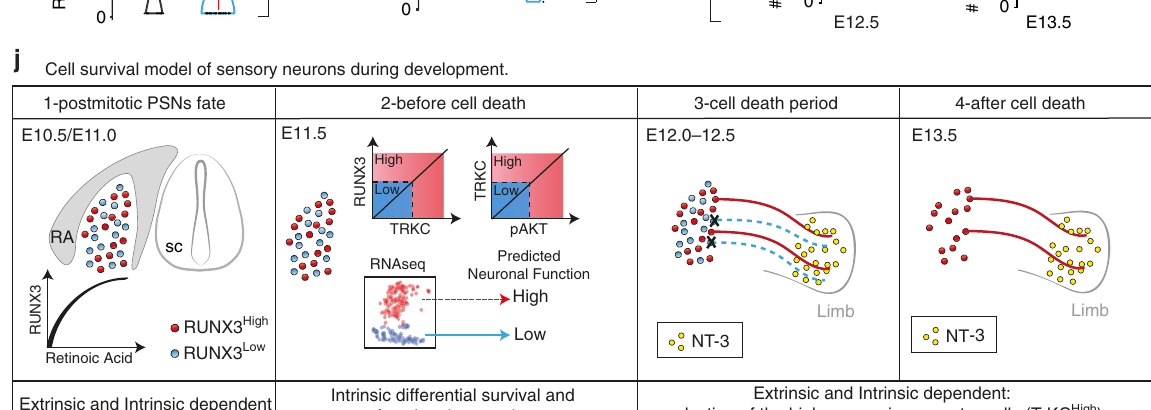
Fig. 6 Retinoic acid signaling regulates induction of RUNX3 expression in PSNs. a Section of the brachial region of an HHst23 chicken embryo showing expression of the RA-synthesizing enzyme RALDH2 at the time of physiological induction of RUNX3. Scale bar: 50 μ m. b RUNX3 expression is induced in the presence of RA (500 ng/ml) in a subset of ISL1 + DRG neurons from HHst23 embryos within 12 h of treatment. Scale bar: 50 μ m. c Concentration- dependent response of RA treatment on RUNX3 levels ( n = 3). d Immunohistochemistry for ISL1, TRKC and RUNX3 on brachial DRG sections from E11.5 WT and Raldh2 − / − mice. Scale bar: 20 μ m. e Quanti fi cation of d , showing no difference in the number of ISL1 or TRKC positive neurons in Raldh2 − / − mice ( n = 3, unpaired Student ’ s t -test). f Quanti fi cation of RUNX3 expression in TRKC + neurons of d shows an overall decrease in intensity ( * P < 0.05, unpaired Student ’ s t -test) and a signi fi cant F test ( F = 0.0009) indicating a larger spreading of the variance between Raldh2 + / + and Raldh2 − / − mice ( n = 3). g Quanti fi cation of TRKC expression in d shows signi fi cant decrease in its level of intensity per cell in the Raldh2 − / − compared to Raldh2 + / + mice ( *** P < 0.001, unpaired Student ’ s t -test). h Quanti fi cation of TRKC + /RUNX3 + DRG neurons on sections from E12.5 Raldh2 + / + and Raldh2 − / − mice shows a twofold decrease in the number of PSNs in the mutants ( ** P < 0.01, unpaired Student ’ s t -test, n = 4). i Number of PSNs is also largely decreased at E13.5 in the Raldh1/2/3 cKO ( R cKO ) mutant mice compared to the control mice Raldh1/2/3 ( Cre − / − ) ( n = 3, * P < 0.05, unpaired Student ’ s t -test). j Proposed model for the selection of the TRKC DRG neurons during development, in which neurons, soon after being generated, feature different functional molecular signatures that are predictive of their survival or death during the cell death period (E12 – E12.5). Source data are available as a Source Data fi